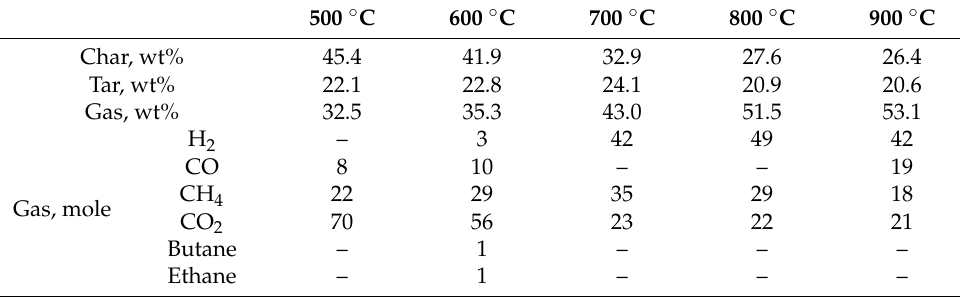
Table 26. Gas composition at different temperatures—pyrolysis